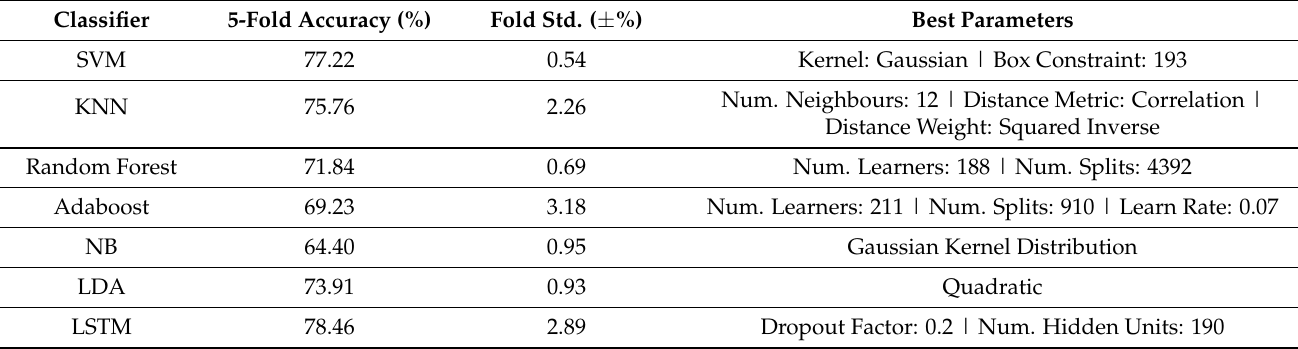
Table 5. Comparisons of Supervised Classifiers under 5-fold Cross Validation and the best suited hyperparameters for each.